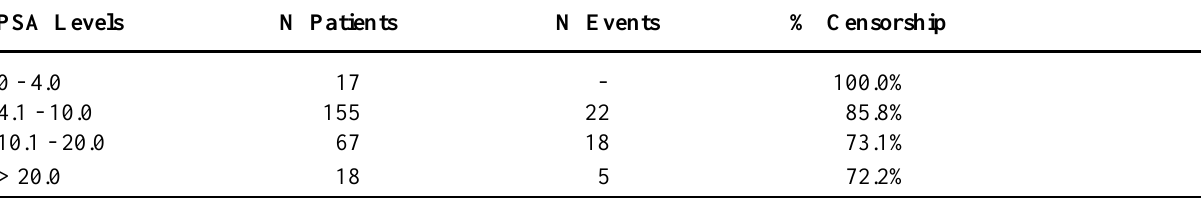
Table 4 – Distribution of patients with clinical stage T1c and Gleason scores 2 - 8, according to PSA